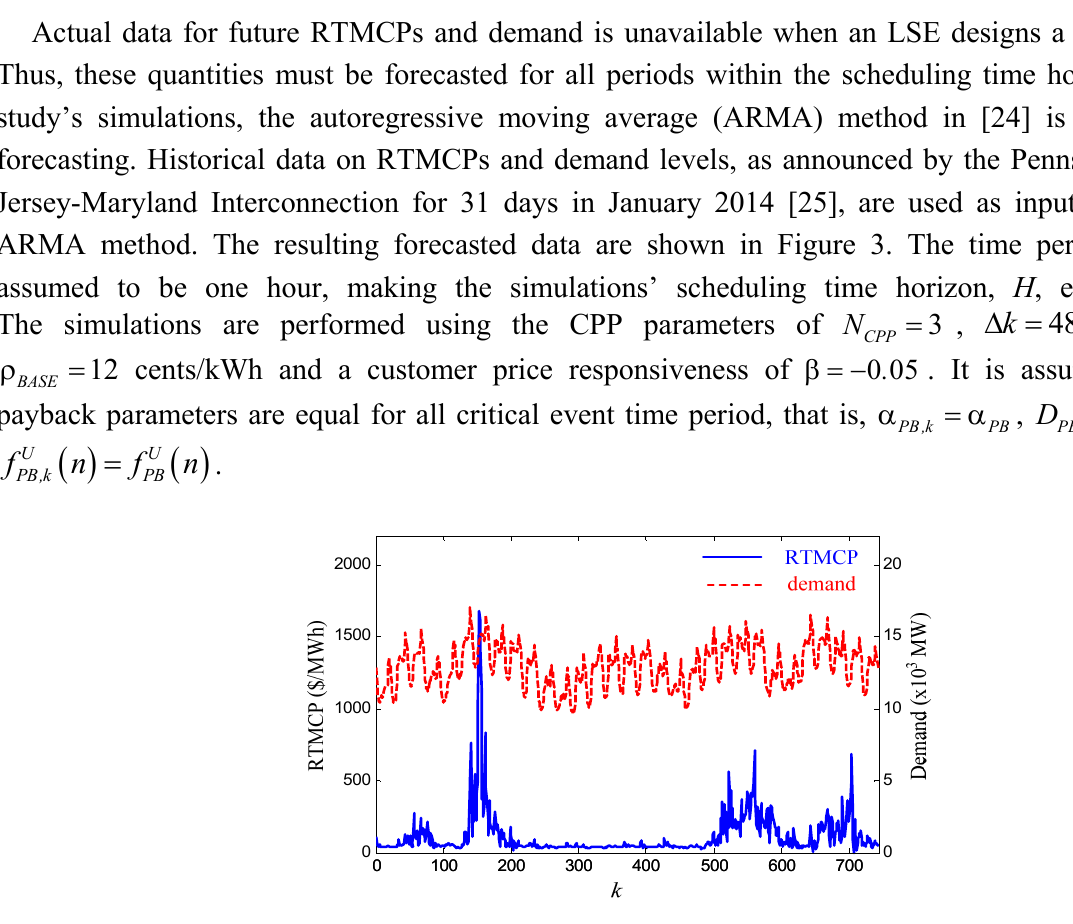
Figure 3. Forecasted data for real-time market clearing price (RTMCP) and